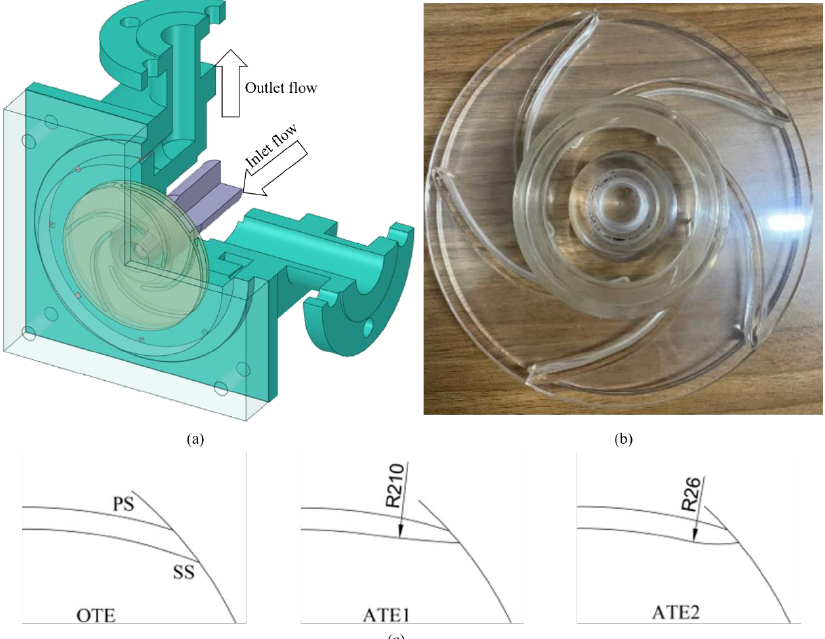
Figure 1. Experimental apparatus: ( a ) model pump; ( b ) the transparent impeller; and ( c ) the trailing edge profiles of different blades.